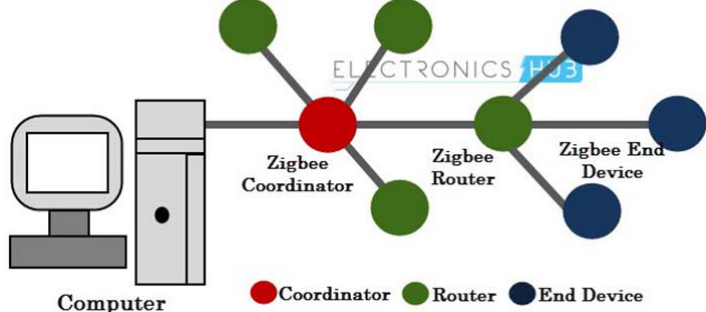
Figure 6. The ZigBee network and its components